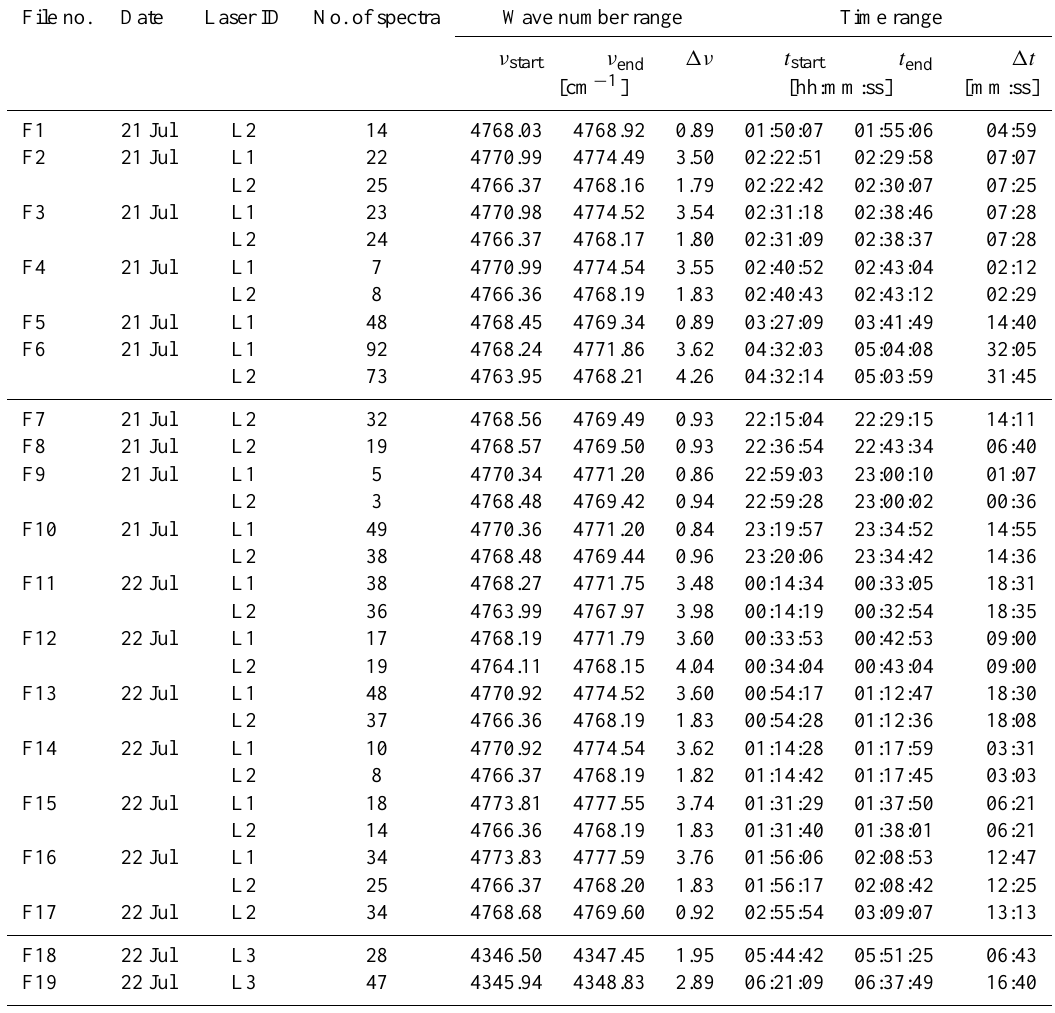
Table 2. Preprocessed infrared-laser link data sets available for the GHG retrieval. For description see Sect. 2.1. File